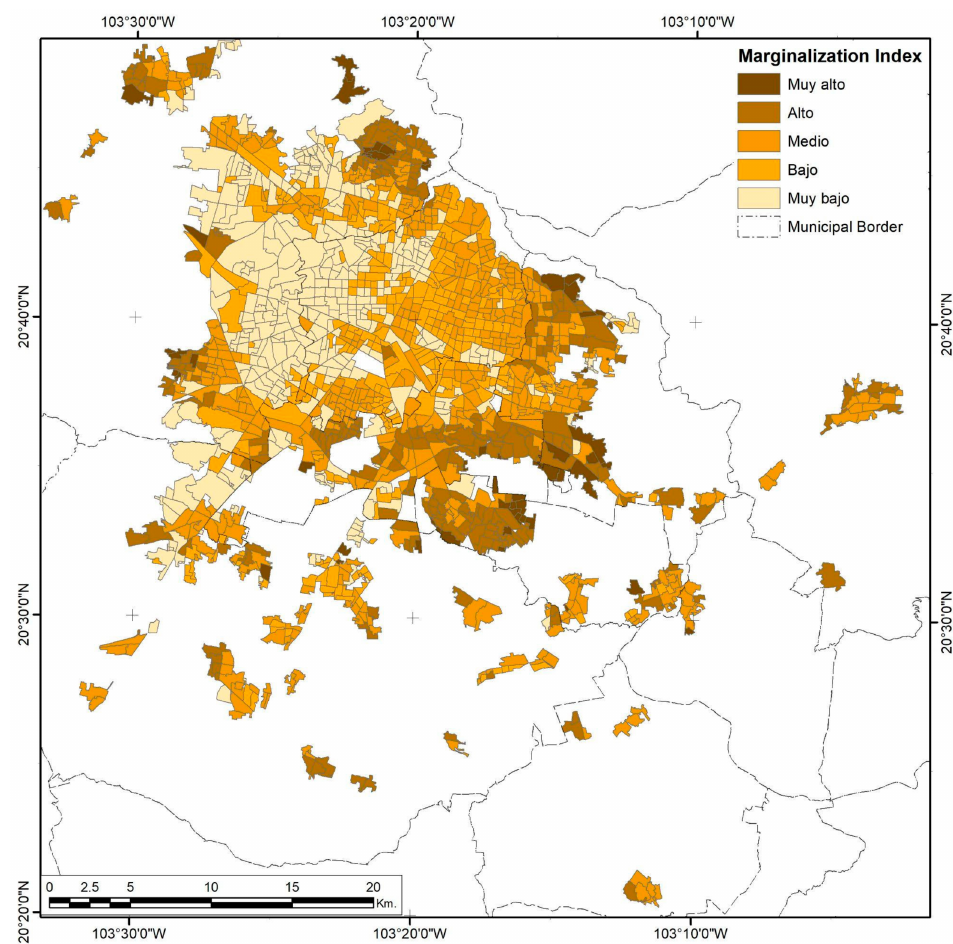
Figure 5. Guadalajara City Urban Marginalization Index (UMI) by AGEB. Developed by the authors with data from